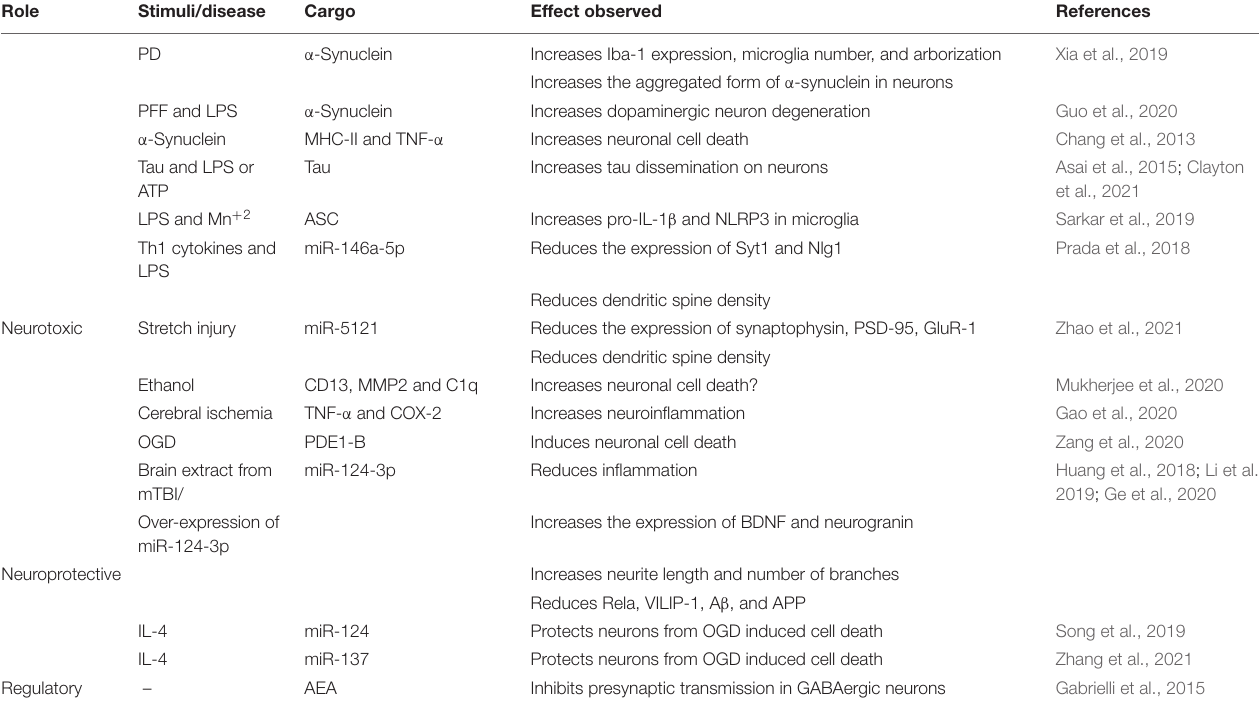
TABLE 2 | Summary of neuroprotective and neurotoxic effects of microglia-derived exosomes with identified